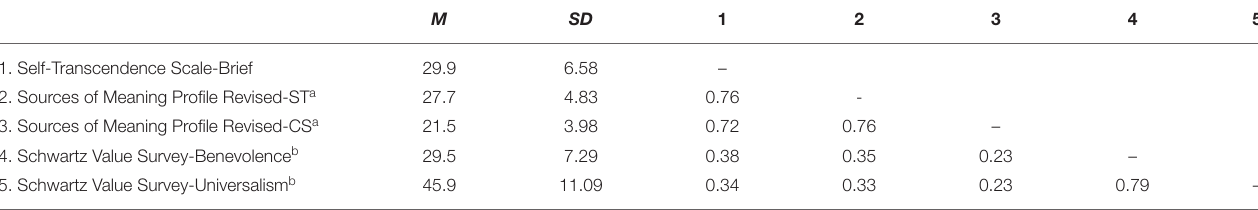
TABLE 1 | Means, standard deviations, and Pearson correlations between STM-B and measures of well-being ( N = 220). M SD 1